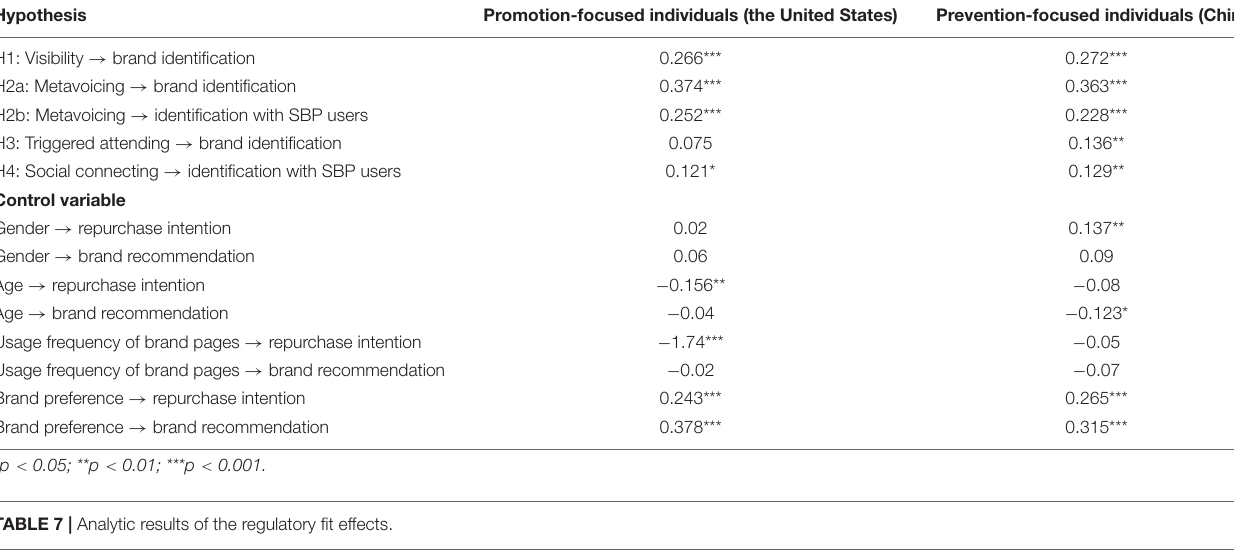
TABLE 6 | Values from model testing on the basis of nations. Hypothesis Promotion-focused individuals (the United States) Prevention-focused individuals (China)